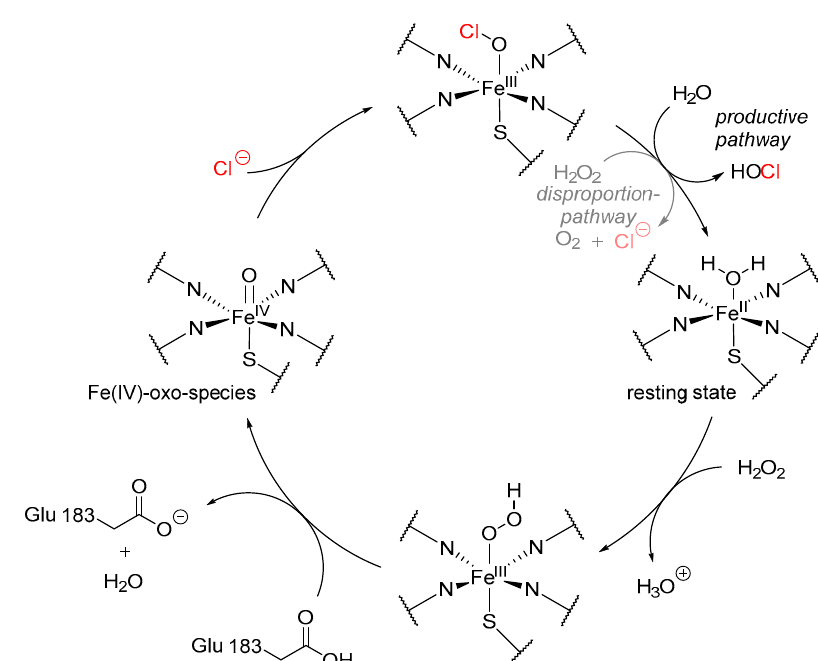
Figure 7. Proposed catalytic cycle of heme-iron-dependent haloperoxidases, shown on the example of CPO from C. fumago . In the resting state (3 o’ clock), water is bound to the heme-iron, which is subsequently replaced by hydrogen peroxide. After protonation of this complex by a catalytic glutamate (Glu183), water is eliminated, creating the actual active species, the Fe(IV)-oxo complex. A halide, in this case chloride, binds to the Fe(IV)-oxo species and is released as hypochloric acid, regenerating the heme-site by hydrolysis with water. Alternatively, another molecule hydrogen peroxide may attack, leading to the disproportion of the complex to molecular oxygen, water, and chloride [54,55].